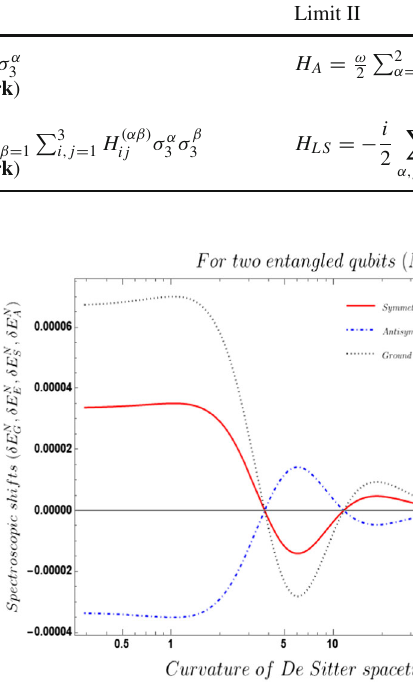
Fig. 1 Behaviour of spectroscopic shifts wrt the euclidean distance between the qubits. The other parameters are kept fixed ( ω = 1 , k ≈ 10 61 ,μ = 0 . 1 ,ω 0 = 1)